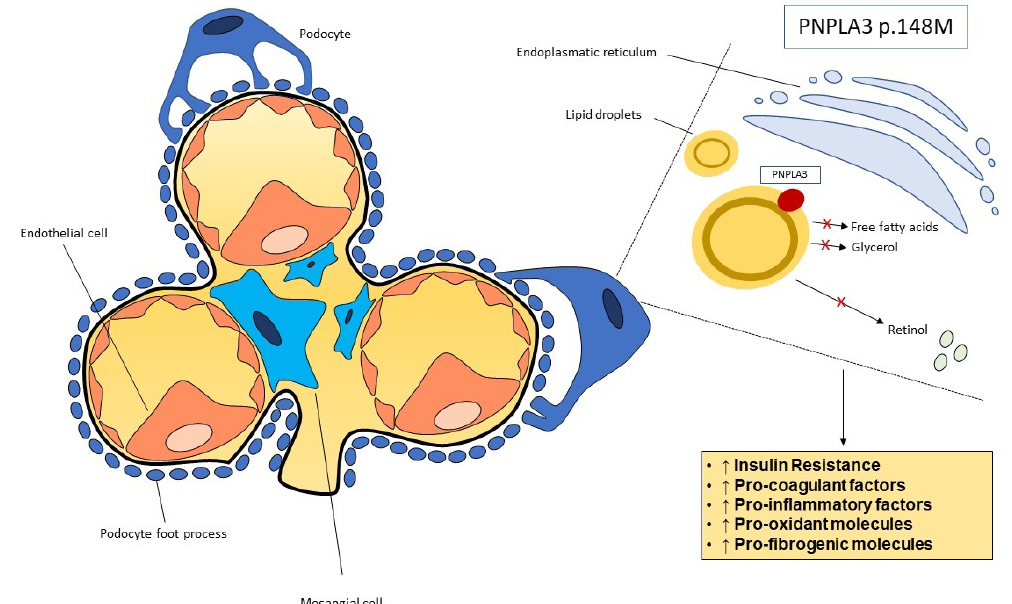
Figure 1. Putative mechanisms underpinning the association between PNPLA3 rs738409 genotype and kidney function. PNPLA3 has a hydrolase activity regarding triglycerides and retinyl esters. It is thought that in mesangial cells and podocytes PNPLA3 might be located in the lipid droplets. The I148M mutation leads a diminution of function of the protein with an excessive internment of fat and retinol in cells. The accumulation of lipids and retinol in the kidney cells may promote insulin resistance, oxidative stress and pro-inflammatory cytokines, thus resulting in renal structural and functional